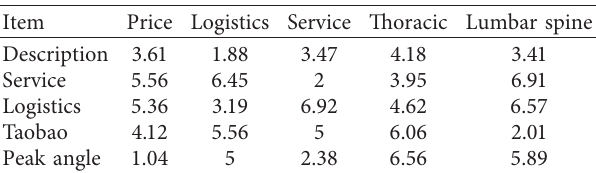
Figure 2: Large-scale mobile e-commerce platforms in China. Table 1: Differences in logistics distribution models of e-commerce